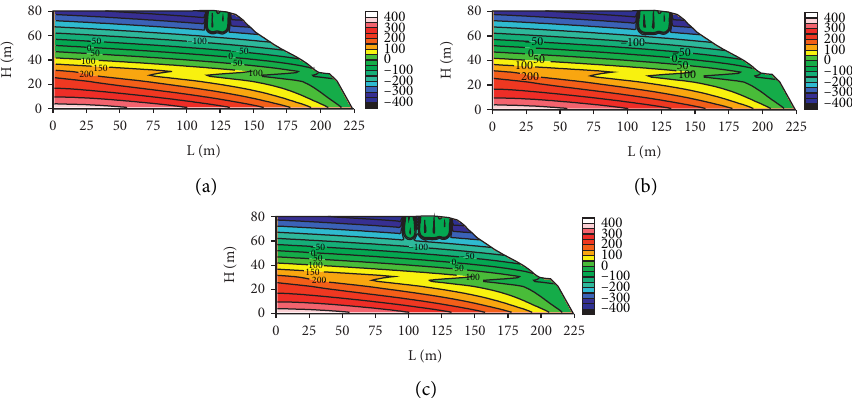
Figure 15: Distribution of pore pressure (kPa) in the slope body of different number of fissures ((a) two fissures; (b) three fissures; and (c) four fissures).